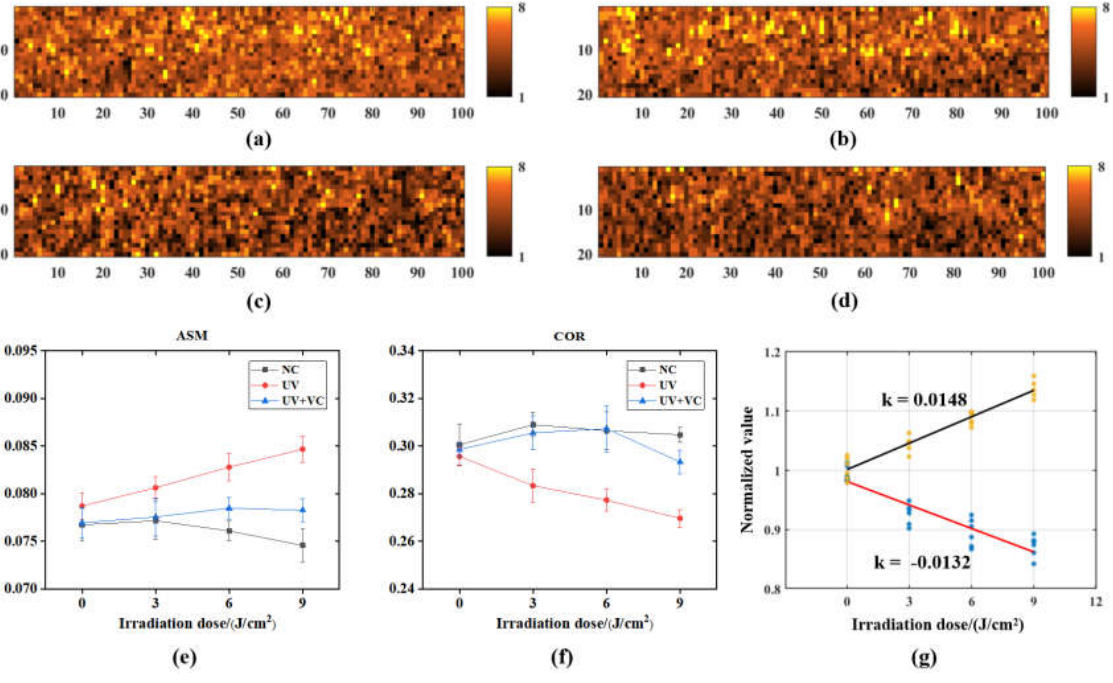
Figure 7. ( a ) Grayscale map of texture before irradiation; ( b ) grayscale map of texture of NC on day 4; ( c ) grayscale map of texture of UV on day 4; ( d ) grayscale map of texture of UV + VD on day 4; ( e ) variation in ASM texture parameters reflecting the internal structural looseness of the skin with incubation time; ( f ) variation in COR texture parameters reflecting the internal structural orientation consistency of the skin with incubation time; ( g ) linear fit of texture parameters of the UV group of AS with UVA irradiation dose.